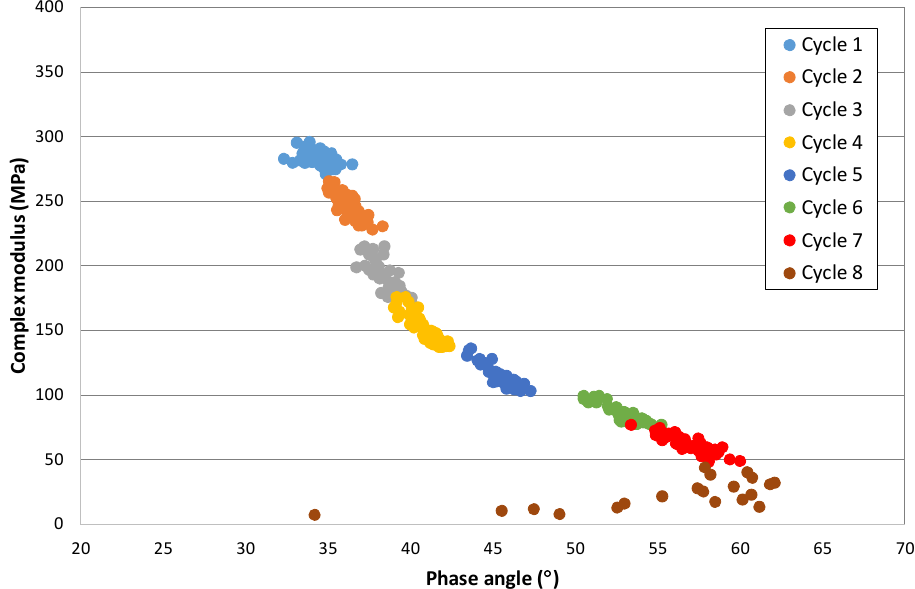
Figure 5. Variation of the modulus with the phase angle at 10 °C (50/70 penetration bitumen).